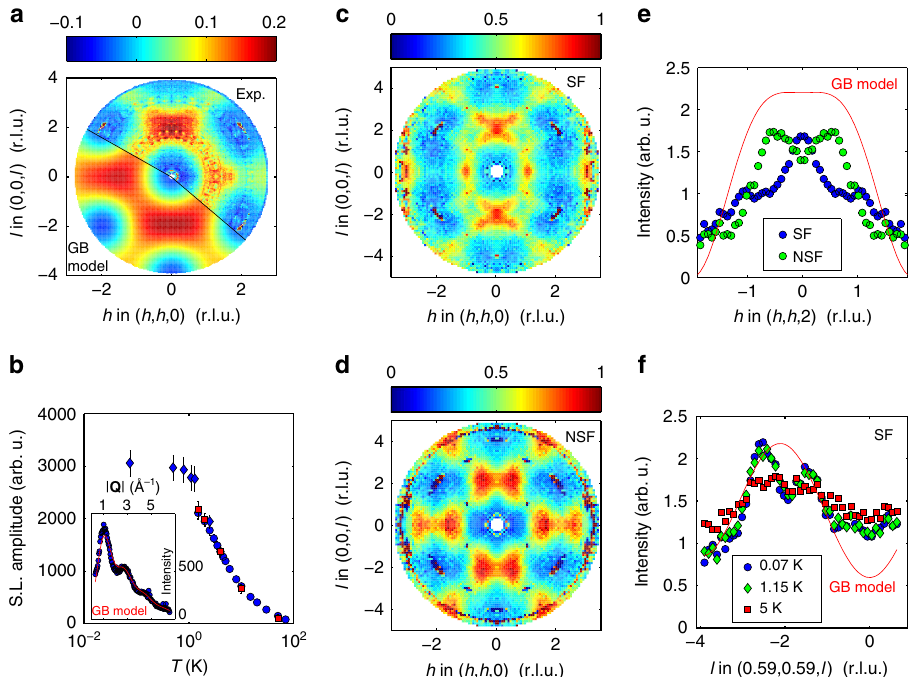
Fig. 3 Spin correlations in Tb 2 Hf 2 O 7 measured by neutron scattering techniques. a Map of reciprocal space in the ( h , h , l ) plane, in reciprocal lattice units (r.l. u.), of the diffuse magnetic scattering for unpolarized neutrons. Top right (Exp.): single-crystal scattering intensity at T = 1.7 K observed with time-of- fl ight spectroscopy, and integrated over energy transfers [ − 0.2; 0.2] meV after the subtraction of background scattering determined at T = 50 K. Bottom left (GB model): structure factor of an isotropic model of antiferromagnetically correlated spins over a single tetrahedron (the Gardner-Berlinsky model) 40 . b Amplitude of the integrated liquid-like magnetic scattering as a function temperature. The inset shows the magnetic scattering at T = 1.5 K, fi tted with a combination of paramagnetic scattering and the powder average of the structure factor of the Gardner-Berlinsky model 40 . Red and blue points were measured on two separate instruments, and scaled at T = 4 K. The error bars represent the standard deviation of the fi t parameter. c , d In plane/spin fl ip c and out of plane/non-spin fl ip d scattering maps, measured at T = 0.07 K using neutron polarization analysis, symmetrized and unfolded. e Cuts through the data of c , d showing the spin fl ip and non-spin fl ip scattering of polarized neutrons measured along the wave-vectors ( h , h ,2). The red curve shows the result of the Gardner-Berlinsky model. f Spin- fl ip scattering of polarized neutrons at three different temperatures along the wave-vectors (0.59,0.59, l ), showing the build-up of magnetic correlations below T = 5 K, but no change between T = 0.07 and T = 1.15